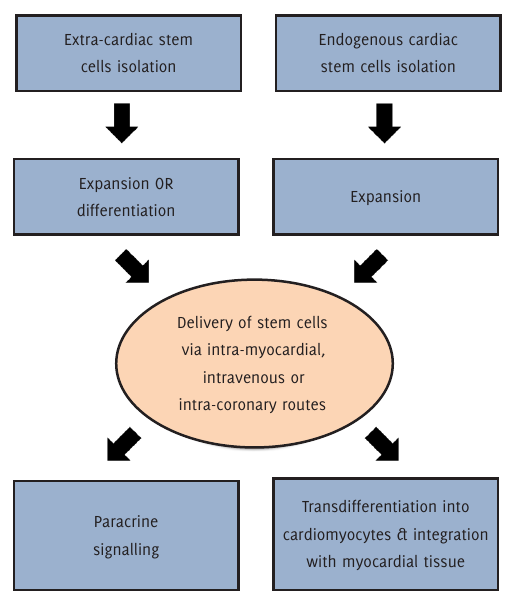
A schematic representation of the potential sequence of events involved in successful regenerative stem cell treatment of cardiac muscle in an infarcted